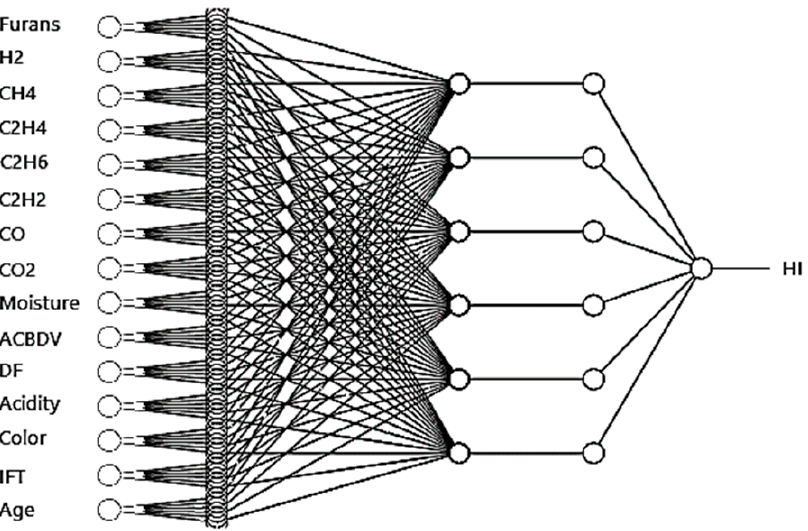
Figure 2. Neural-Fuzzy (NF) network architecture. ACBDV: AC breakdown voltage; DF: dissipation factor; IFT: interfacial tension.